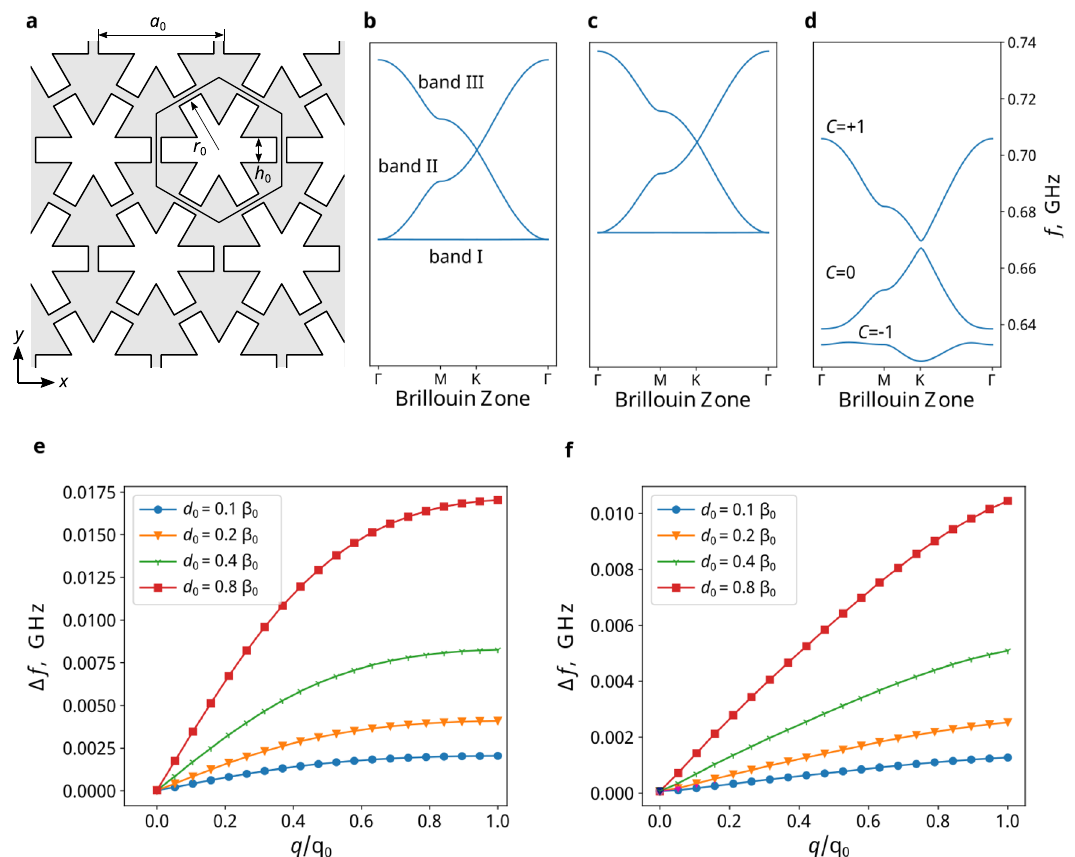
Fig. 1 | Time-reversal symmetry breaking in charge-doped PZM phononic crystals. a Schematic of the phononic crystal design. Within each hexagonal unit cell, a snow fl ake-shaped white region is etched away. The geometrical parameters (a 0 =2.3 μ m, r 0 =1 μ m, h 0 =0.5 μ m) are kept the same for panels. The band struc- tureisvariedwhenthebulkmaterialchangesfrom( b )apureelasticmaterialto( c )a charge neutral PZM material and to ( d ) a PZM material with a uniform doping